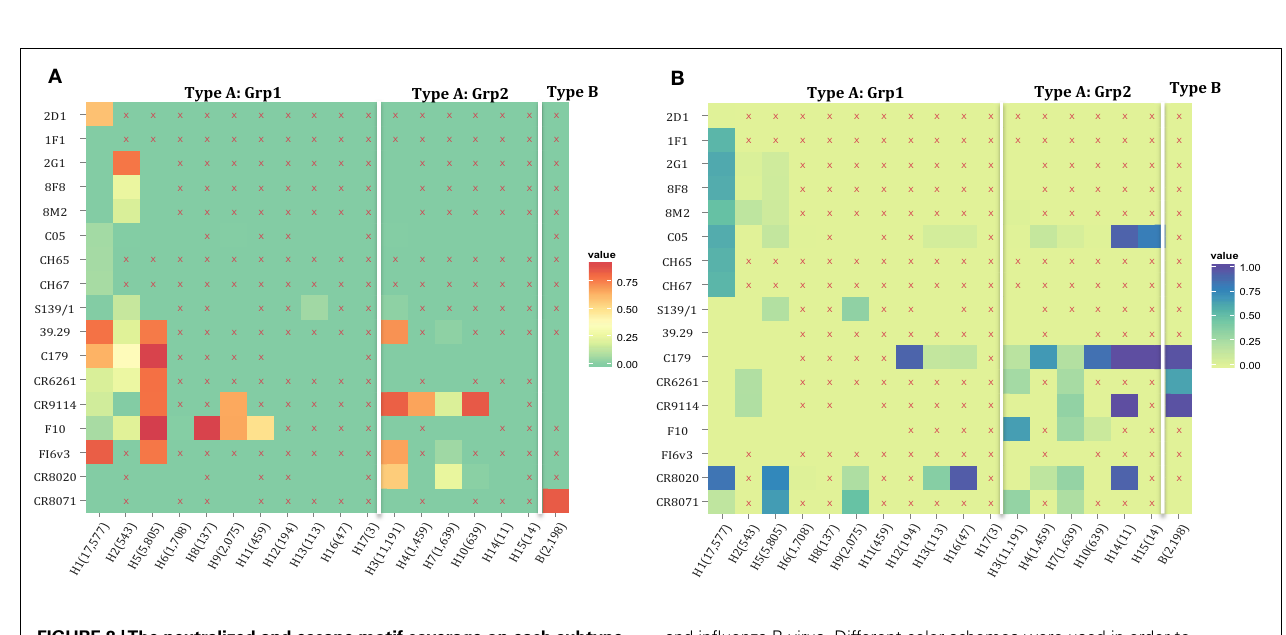
their binding locations and influenza types, from left to right: Sa site, near RBS, F subdomain, stem base on influenza A virus, and head base on influenza B virus.